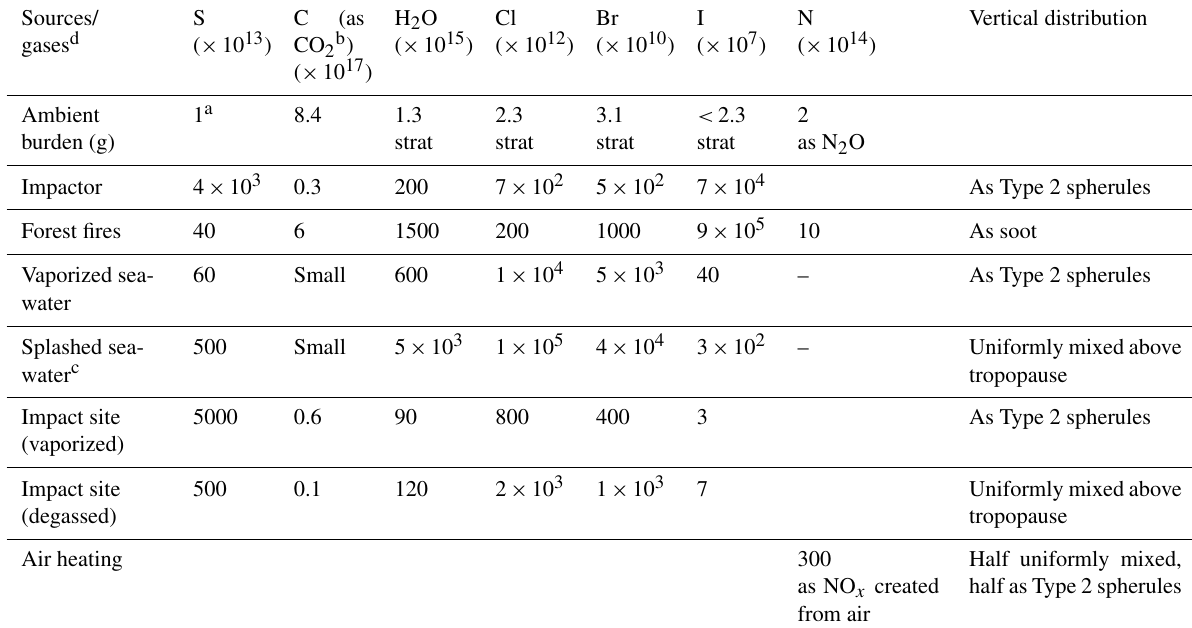
Table 2. Gas-phase emissions (g) from the Chicxulub impact.